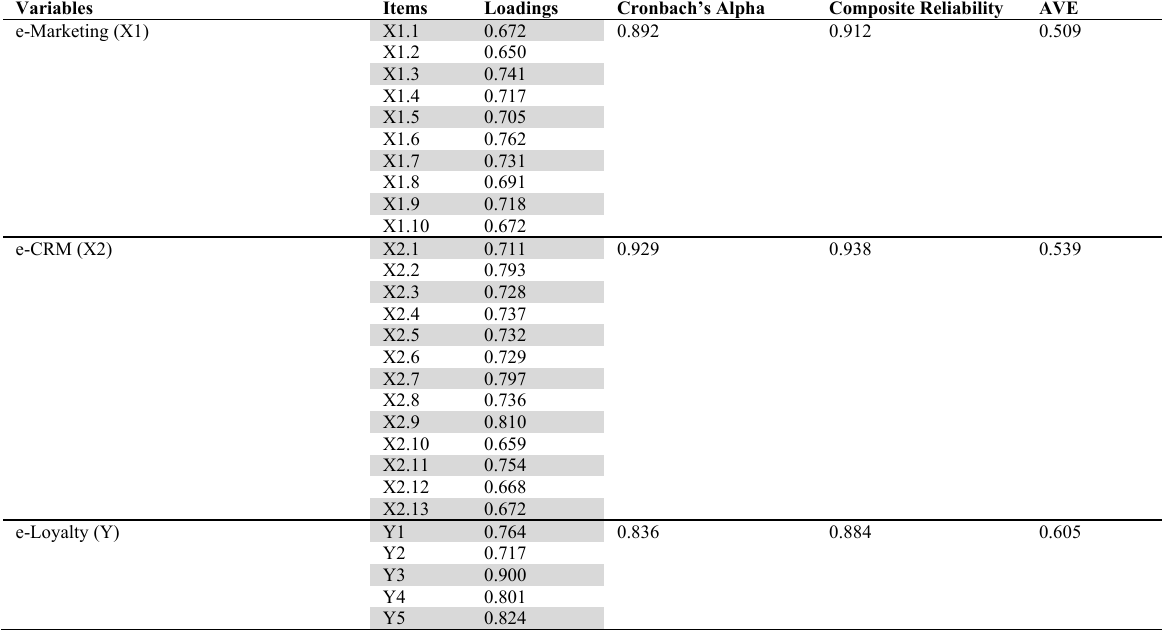
Items Loadings, Cronbach’s Alpha, Composite Reliability, and Average Variance Extracted (AVE) Variables